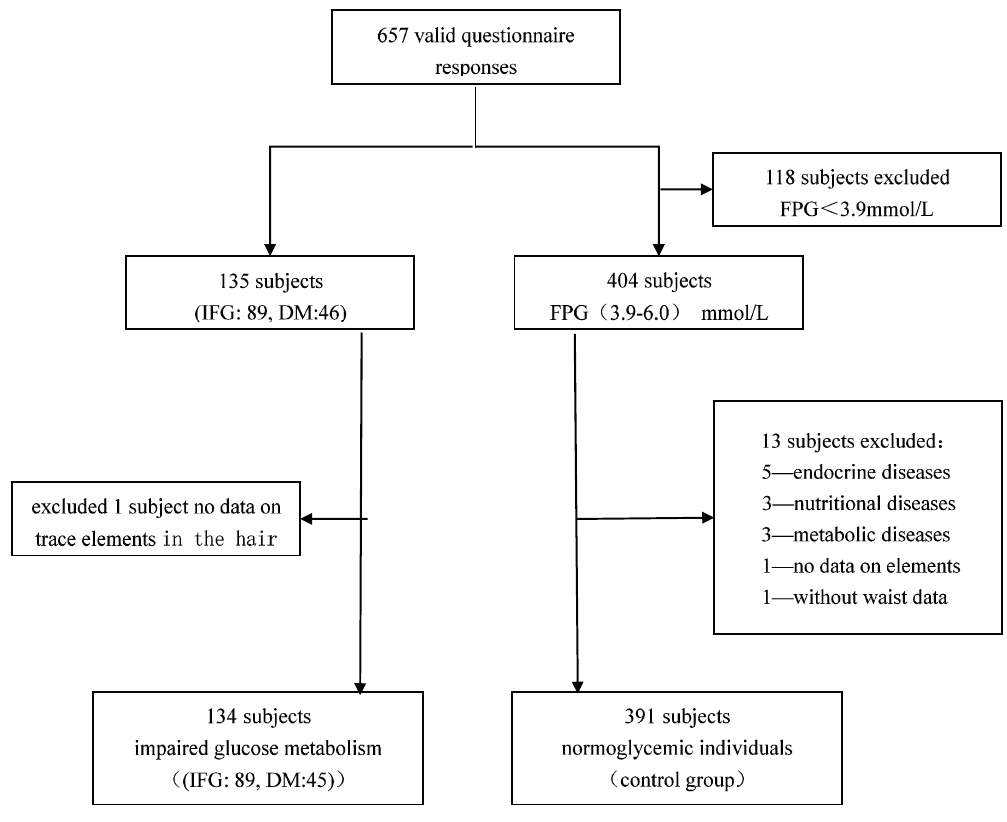
Figure 1. Flow diagram of patient